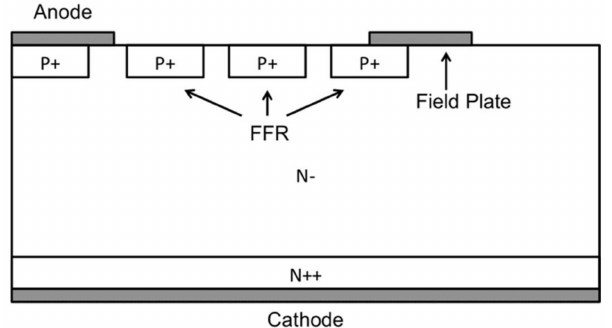
Figure 8. A sketch of the termination area.